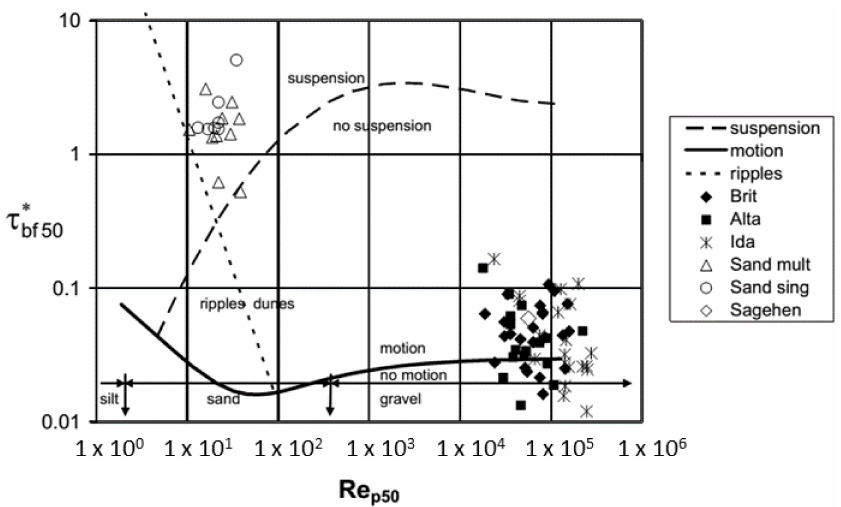
Figure 3. Shields–Parker diagram